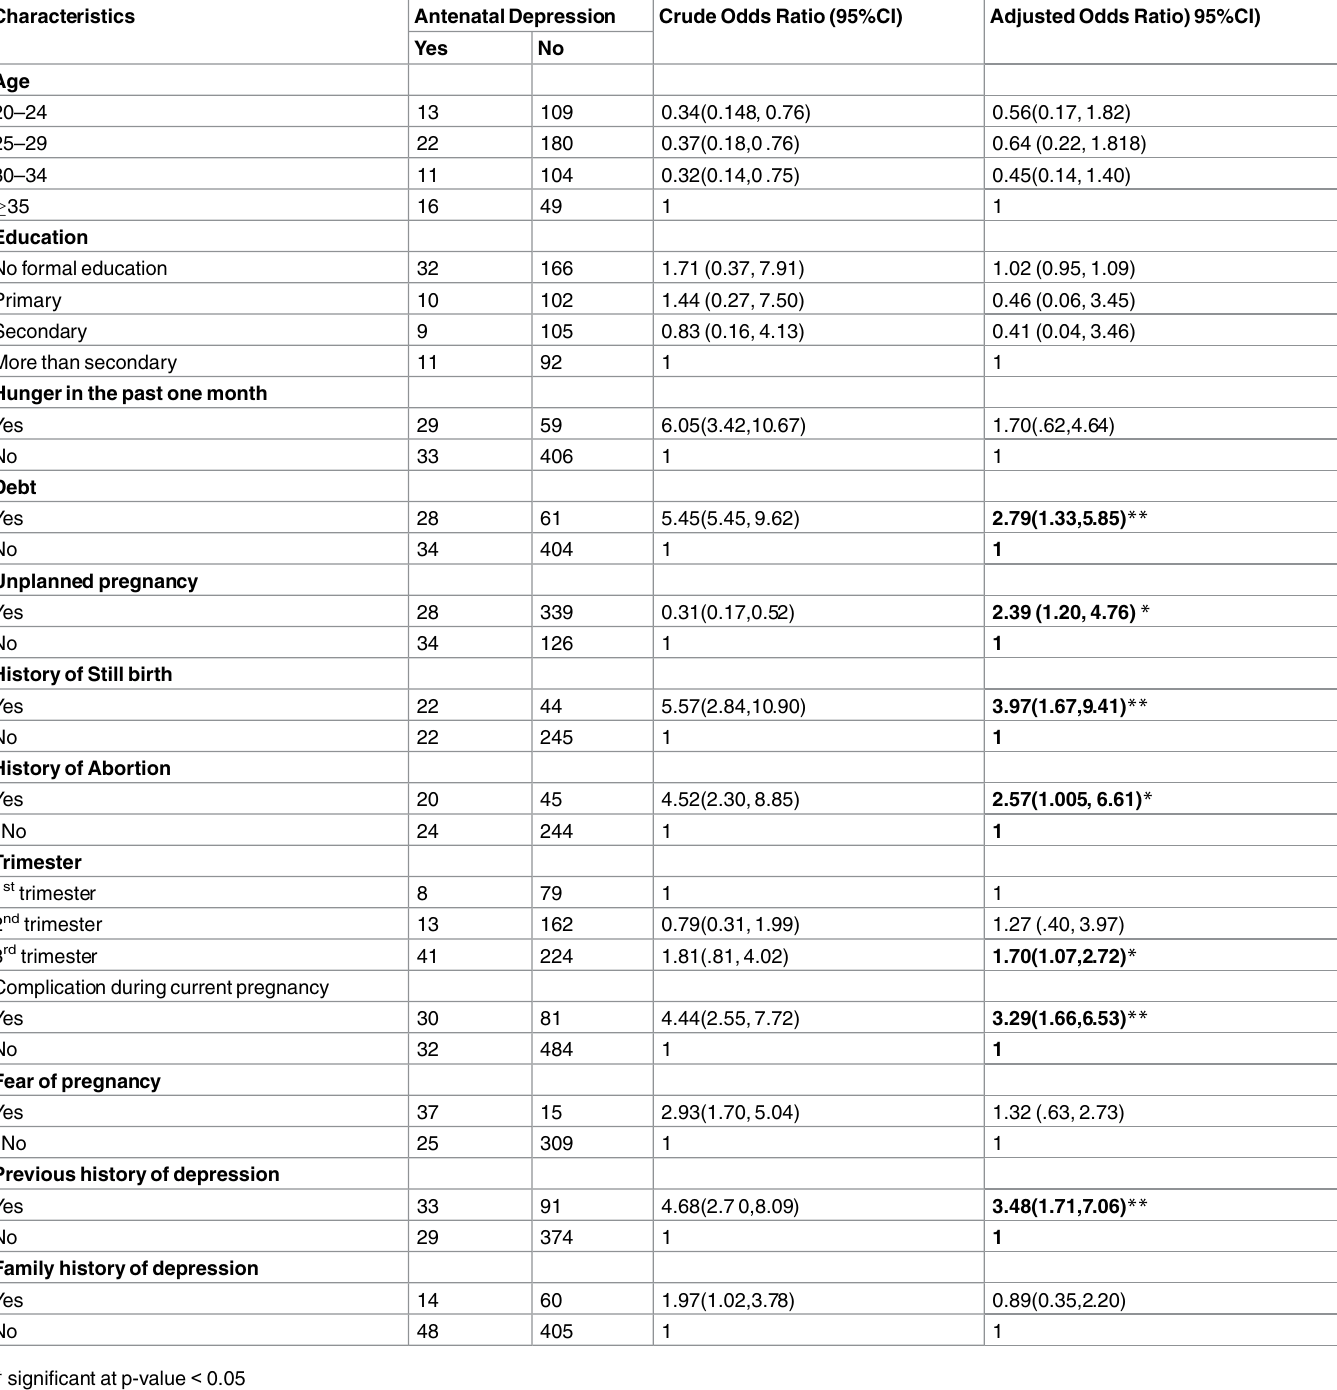
Table 2. Demographic and obstetric factorsassociatedwithdepression amongpregnant women at Debretabortown, NorthWest Ethiopia,2013.